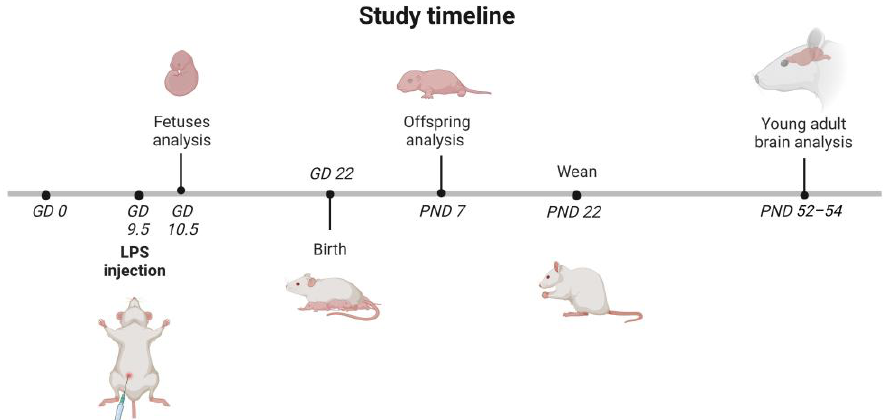
Figure 1. Timeline of the study. LPS (100 µg/kg b.w.) was injected intraperitoneally (i.p.) into pregnant rats at gestation day 9.5 (GD 9.5), and the control animals received a single i.p. dose of solvent (sterile 0.9% NaCl). Some of the pregnant mothers were sacrificed 24 h after the LPS administration (GD 10.5). The fetuses were collected for further research. The other dams were allowed to give birth and nurture offspring under normal conditions. The day of birth was recorded as postnatal day (PND) 1. On PND 7, each litter was equalized to 10 (both male and female) and the eliminated pups were sacrificed, their brains were removed, and they were taken for further analysis. On PND 22 to 23, rat pups were separated and housed in groups of 3 or 4. Adolescent males were sacrificed at PND 52–54, their brains were removed, and the cerebral cortex was isolated for further analysis. The figure was created with BioRender.com.